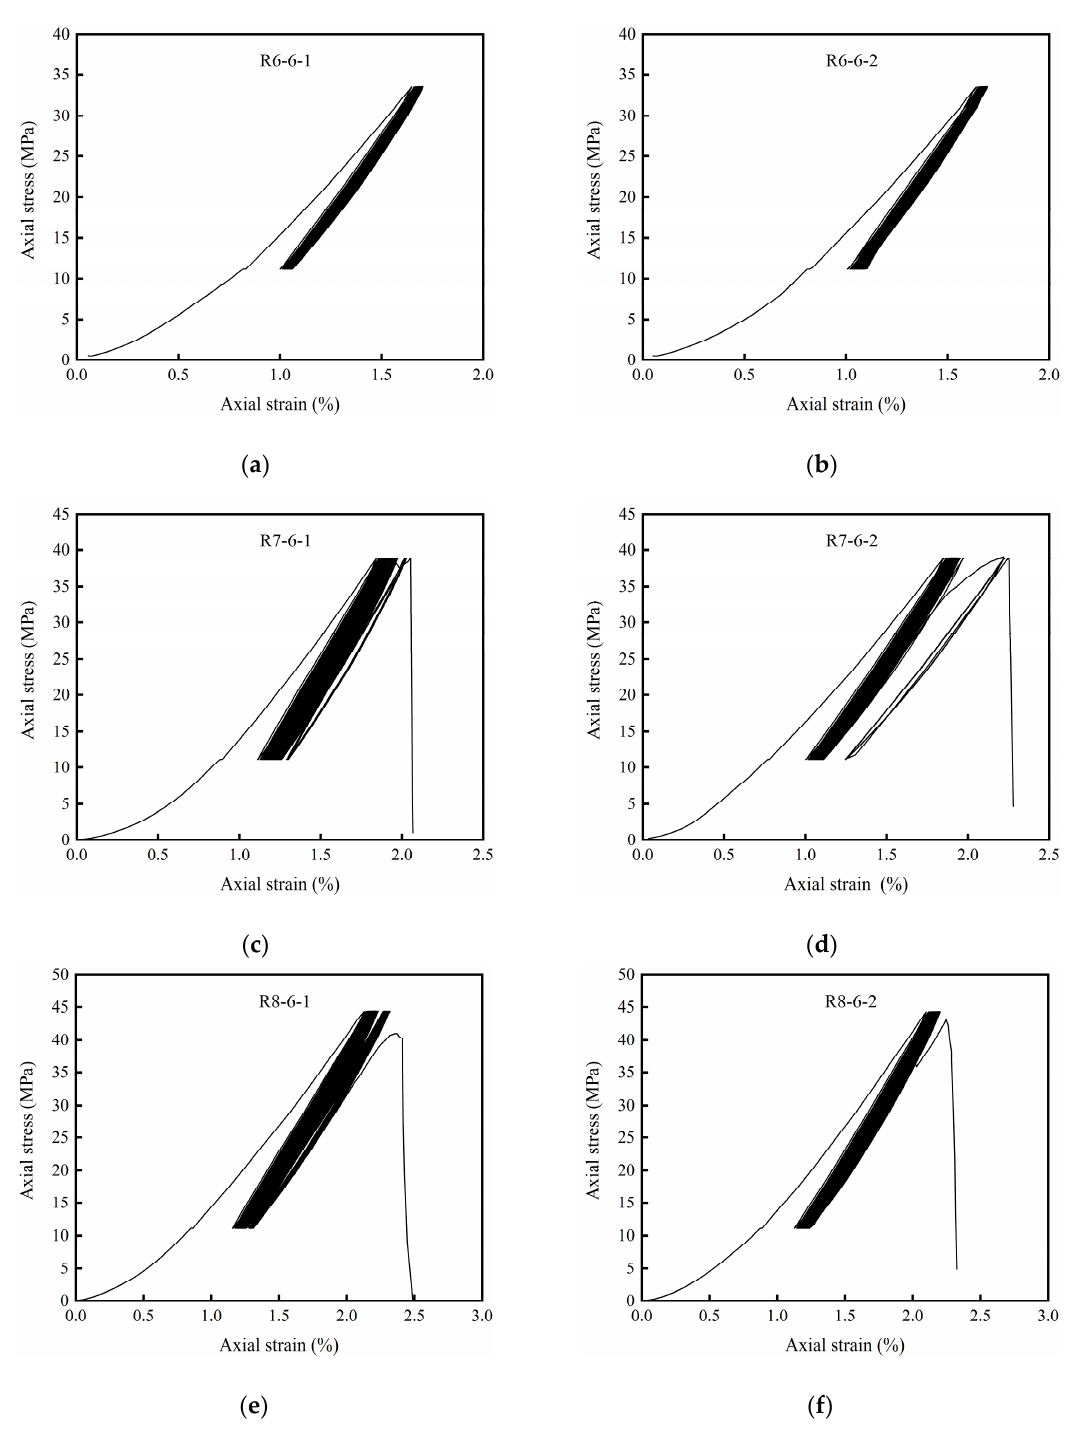
Figure 10. The stress–strain curve of the cyclic loading and unloading test.